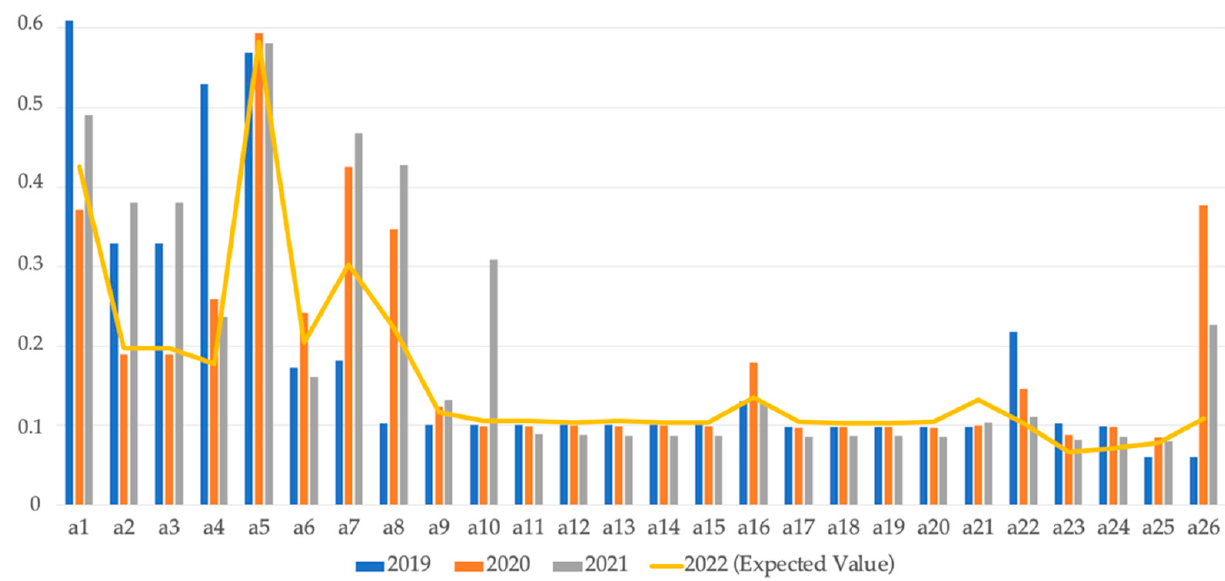
Figure 1. Ranking of alternatives with Dynamic model.